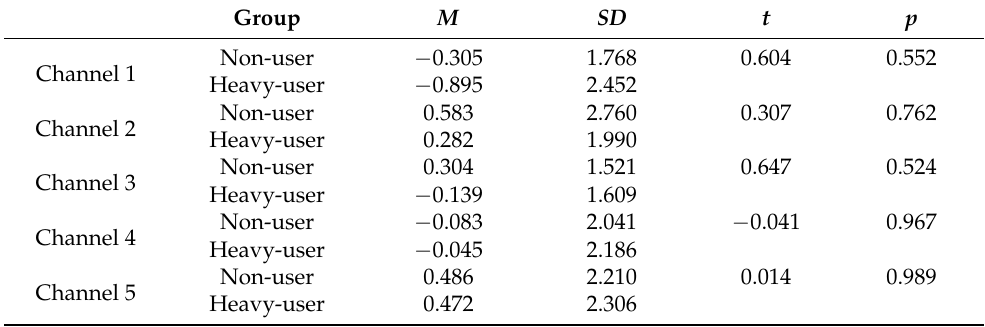
Table 3. Comparison of HbR increase between ‘non-user’ (N 1 = 8) and ‘heavy-user’ (N 2 = 16)